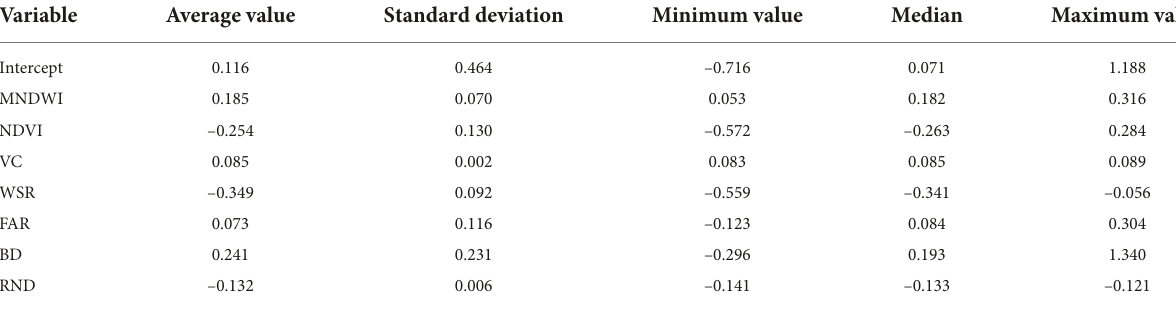
TABLE 6 Results of multiscale geographically weighted regression (MGWR) model operations.